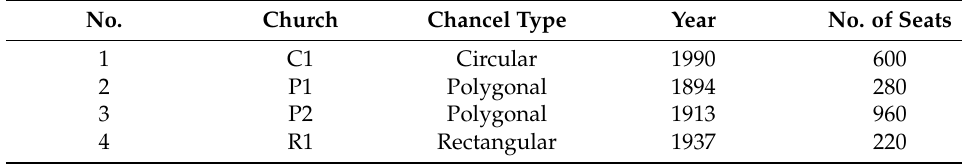
Table 1. Main physical characteristics of the churches in this study. No. Church Chancel